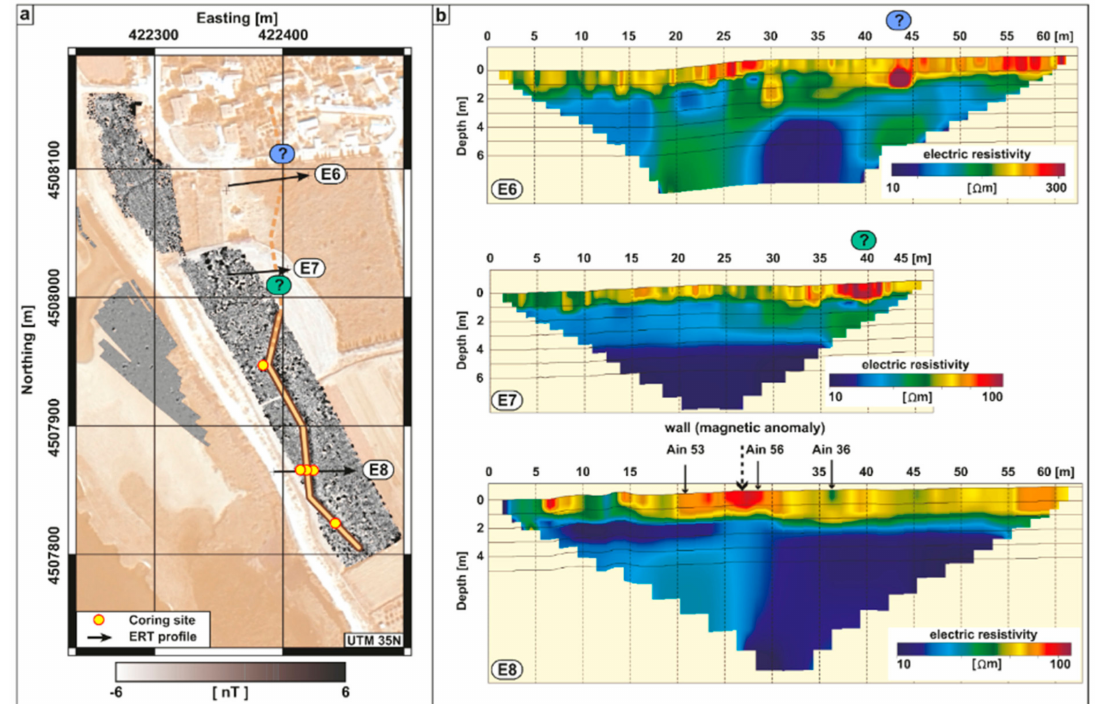
Figure 4. ERT transects in the area of the buried city wall. Wenner & Schlumberger electrode arrangement, electrode spacing 1.0 m. ( a ) Positions of the three ERT profiles E6–E8 shown on the map of the MG results. Profiles E6 and E7 were conducted in an area where no MG measurement had been carried out; ( b ) Simplified inverse model section of ERT profiles E6–E8. The high resistivity values in the area of the ? in E6 and E7 may be best interpreted as remains of the buried wall, which was then confirmed by coring Ain 56 in profile